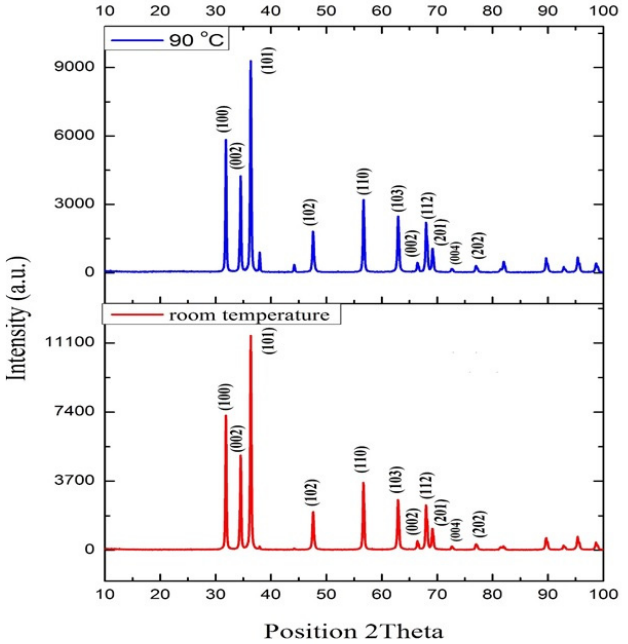
Fig. 1. XRD Pattern of ZnO NPs at room temperature and at 90°C.